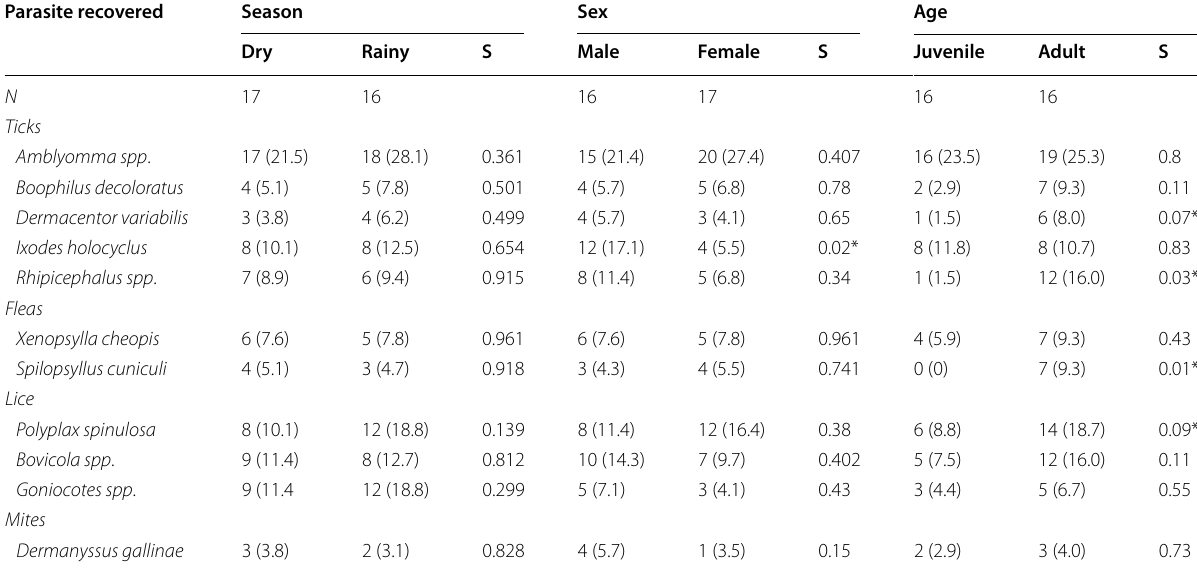
The comparison is between season (dry and rainy), sex (male and female) and age (juvenile and adult) N infected (%), S significance, * p = ≤